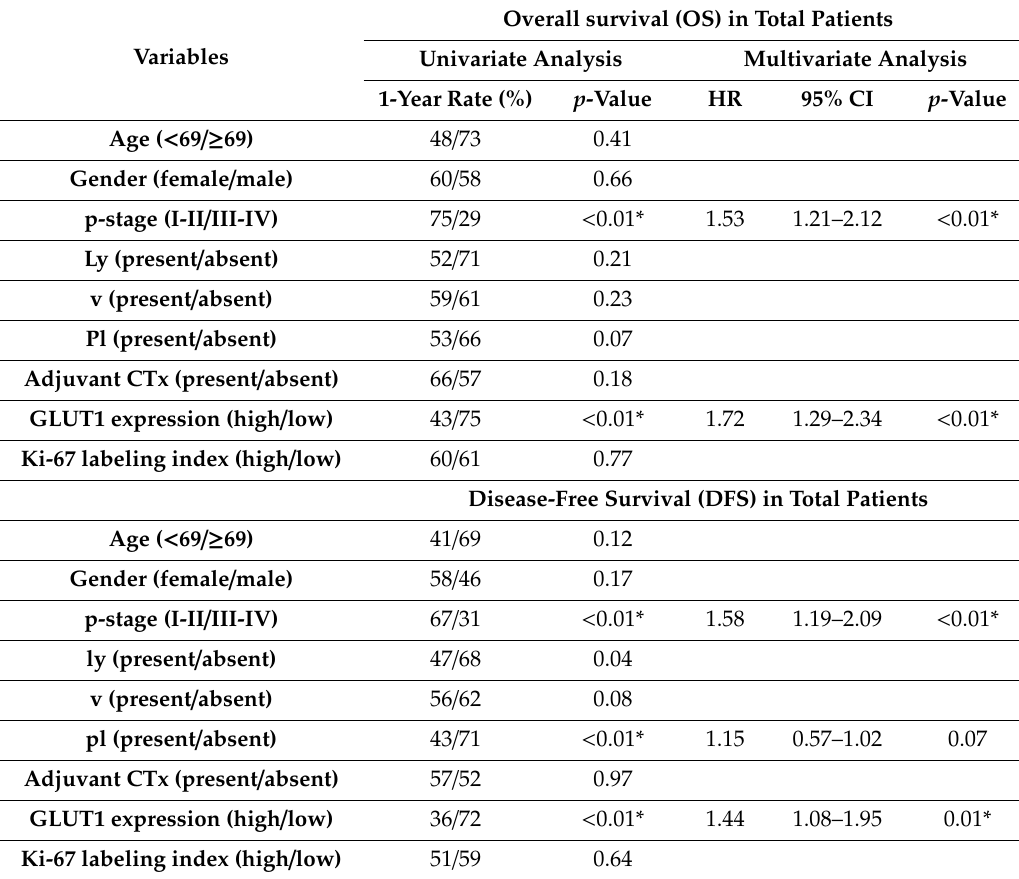
Table 2. Univariate and multivariate survival analysis in all